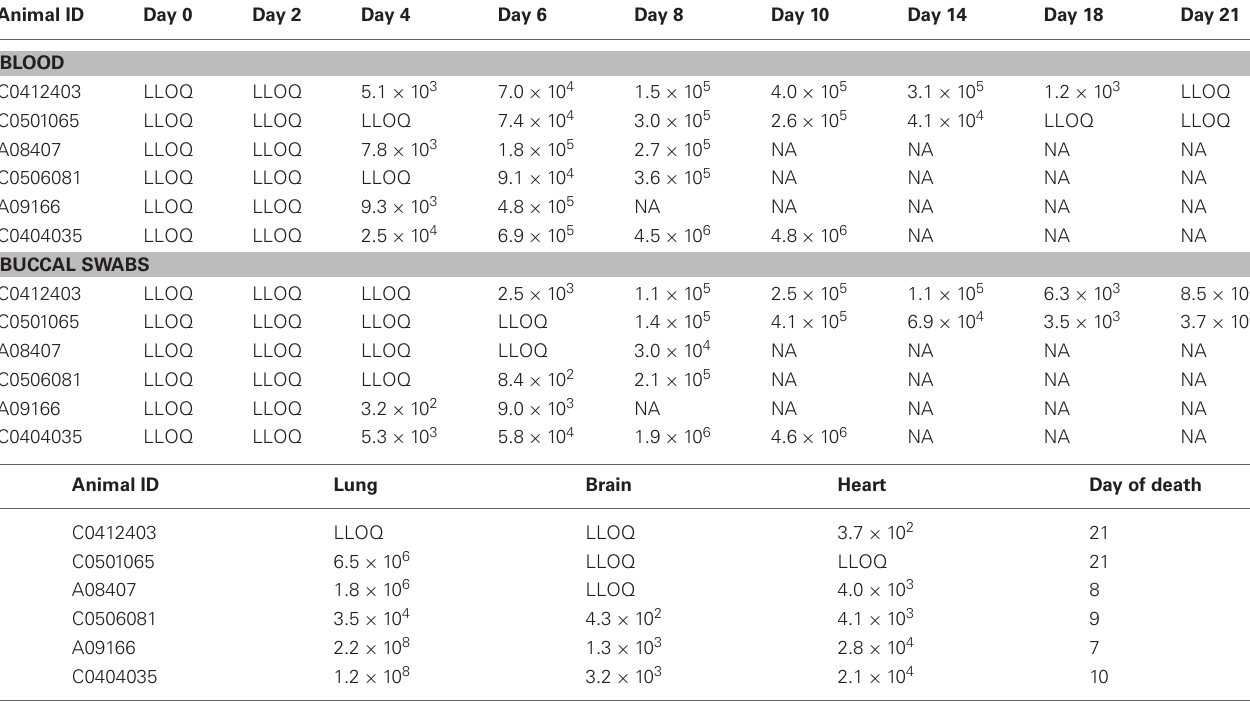
Table 3 | Summary of blood, buccal, and tissue qPCR